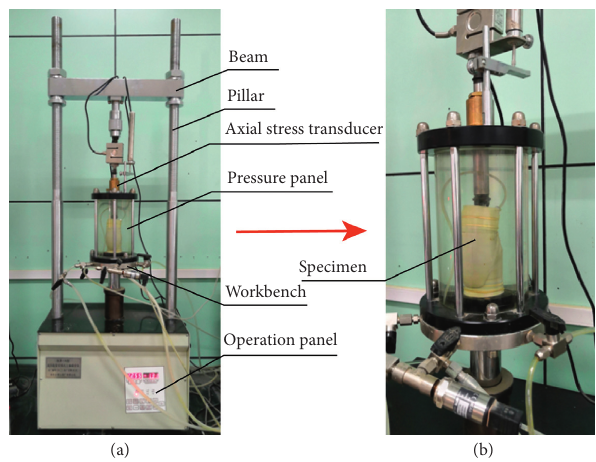
Figure 8: Triaxial creep shear test apparatus: (a) instrument details; (b) creep test